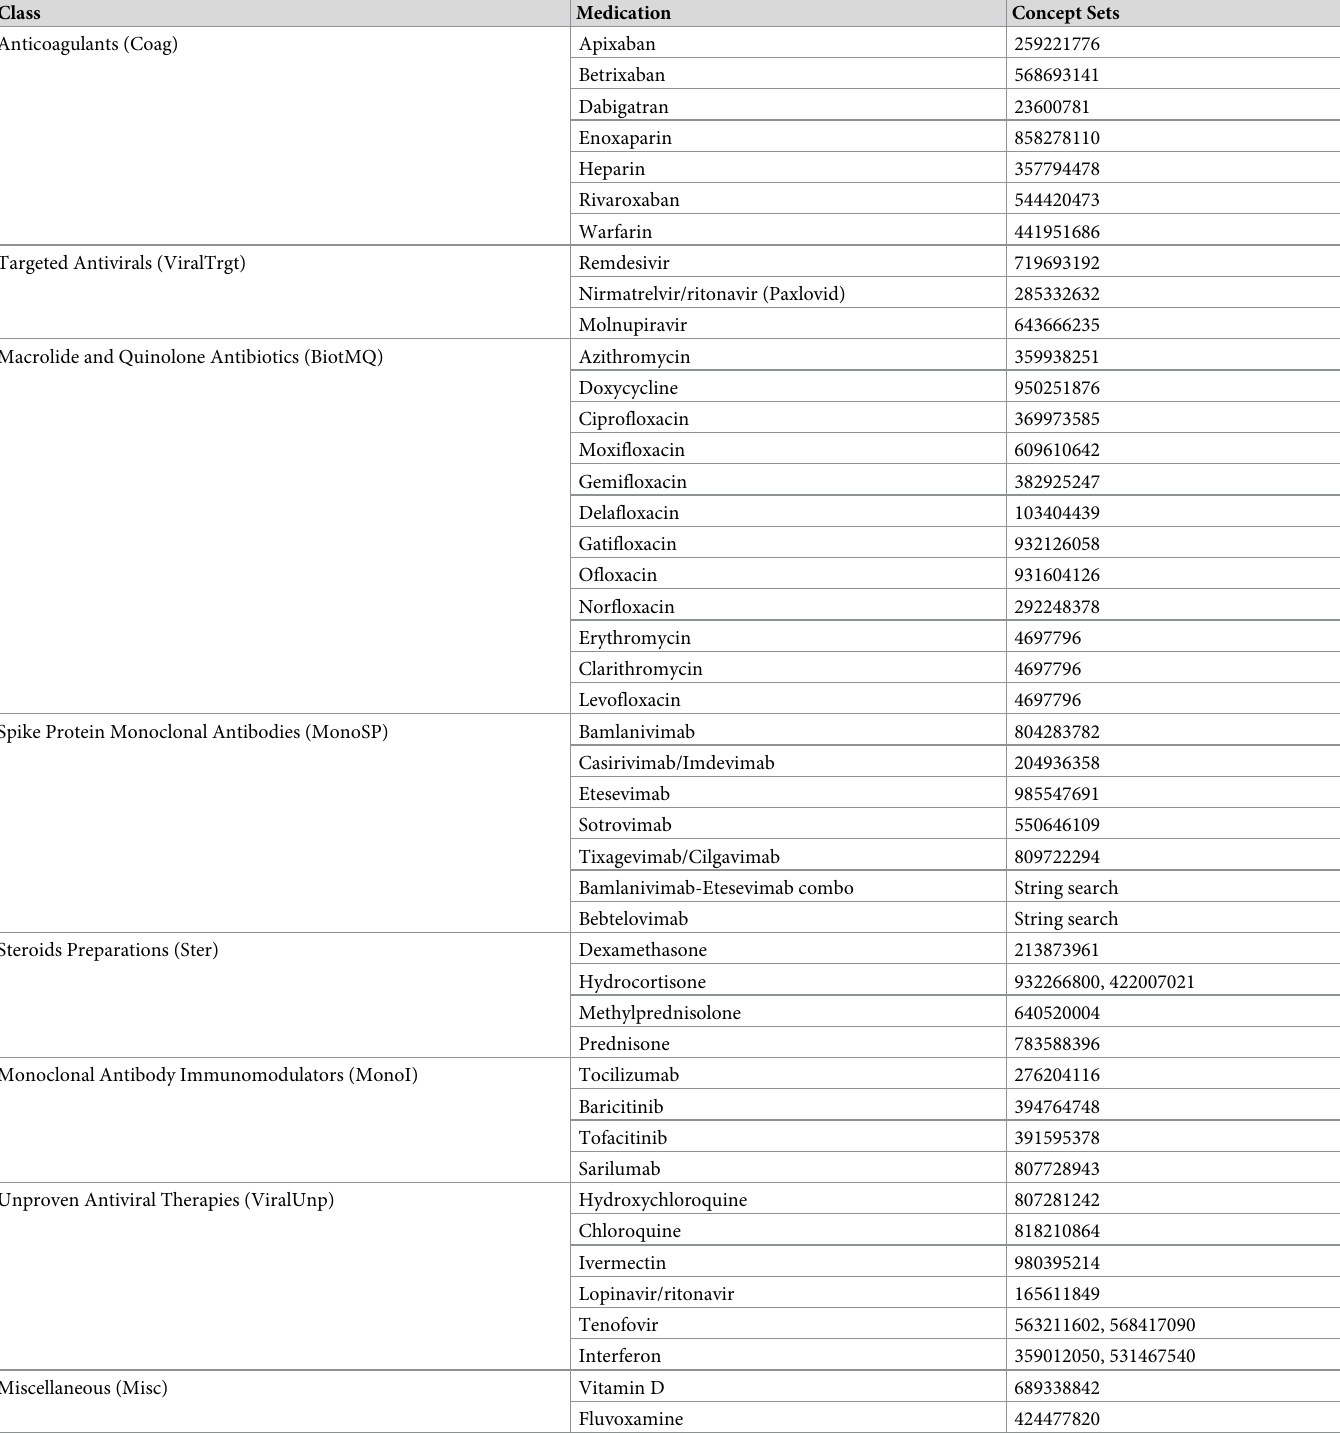
Table 1. Medications in each treatment